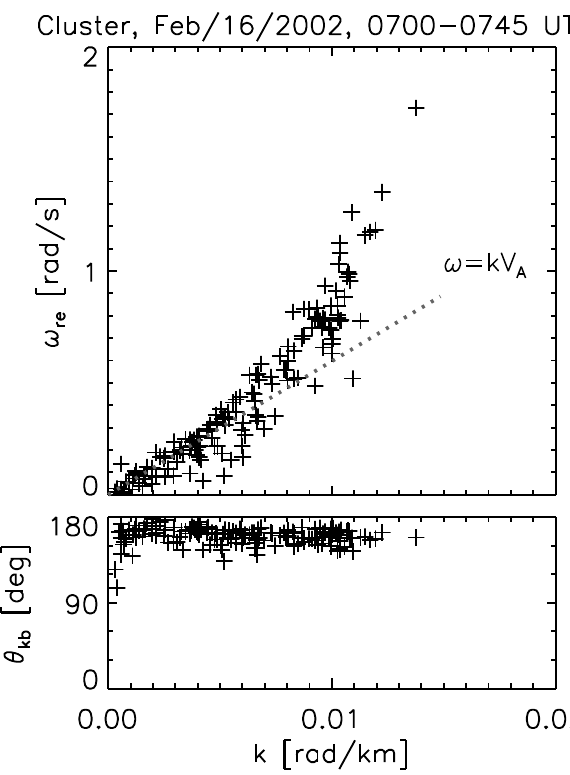
Fig. 4. Experimental dispersion relation of the foreshock waves (top) and propagation angles from the mean magnetic field direc- tion identified by the wave surveyor technique using Cluster mag- netic field data. The frequencies are represented in the plasma rest frame. The ion inertial scale and the ion cyclotron frequency are k in = 0 . 011rad / km and (cid:127) i = 0 . 64rad / s, respectively.